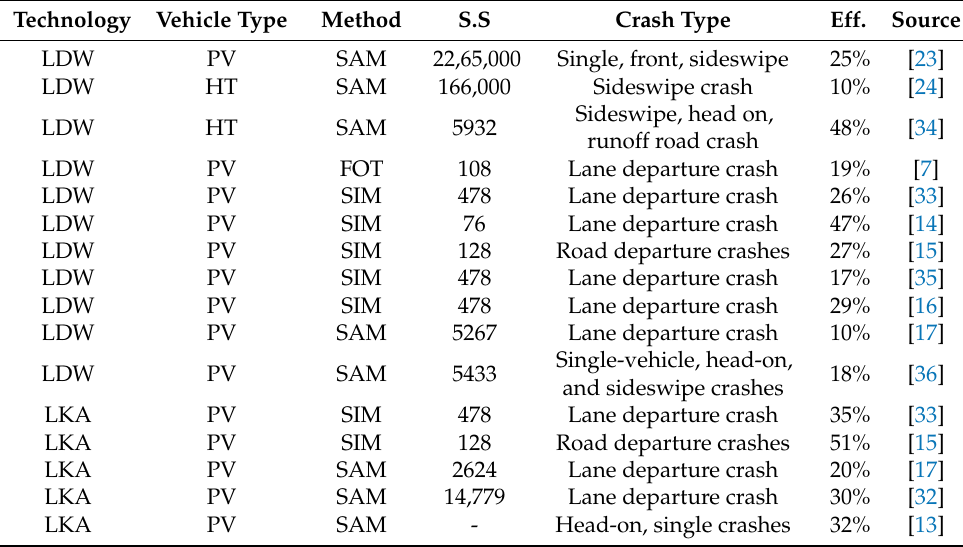
Table 3. Evidence for the crash avoidance effectiveness of LDW and